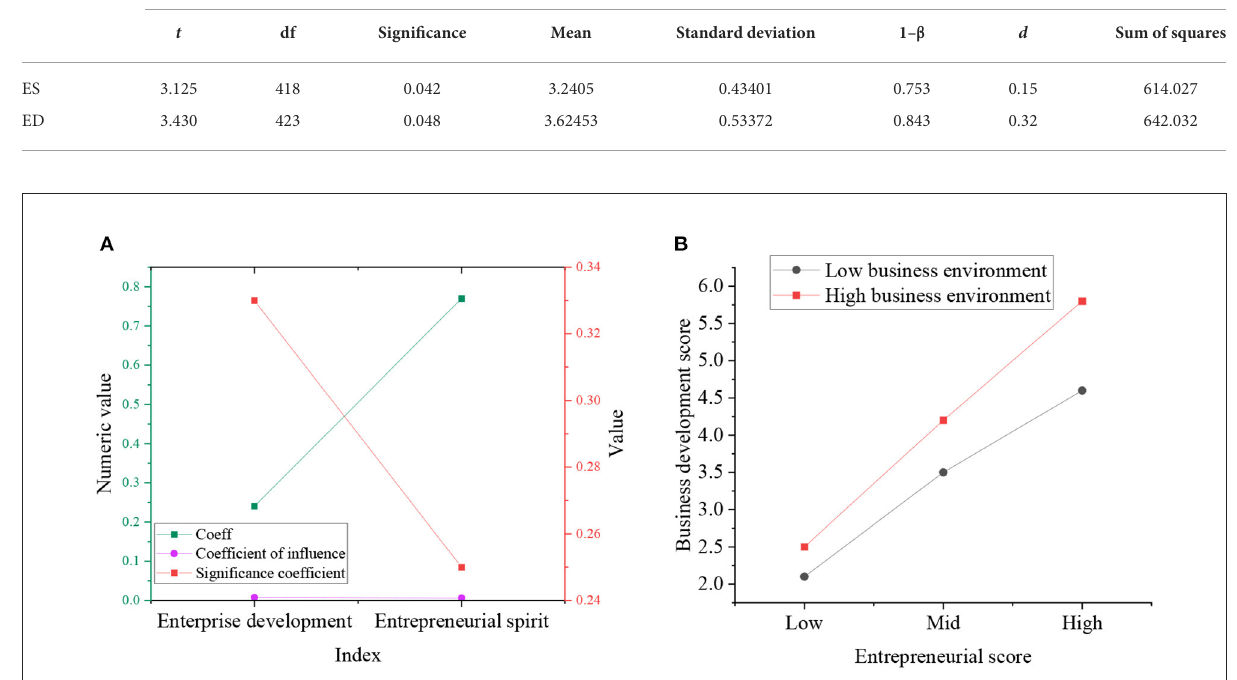
FIGURE10 Bootstrap analysis result diagram (A) Index result diagram; (B) Relationship result diagram.